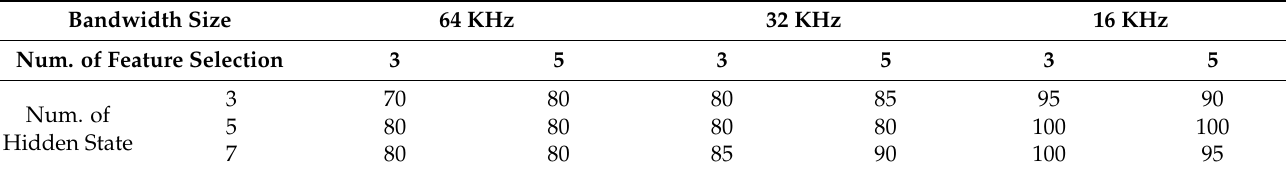
Table 5. Classification rate with AE signals on spindle and 30 observation sequences. Unit (%).